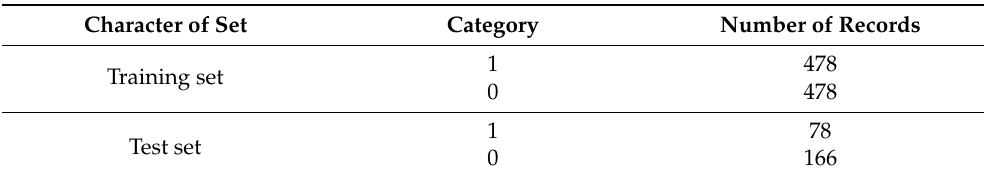
Table 13. Number of records by set type and category of dependent variable after stratification and SMOTE